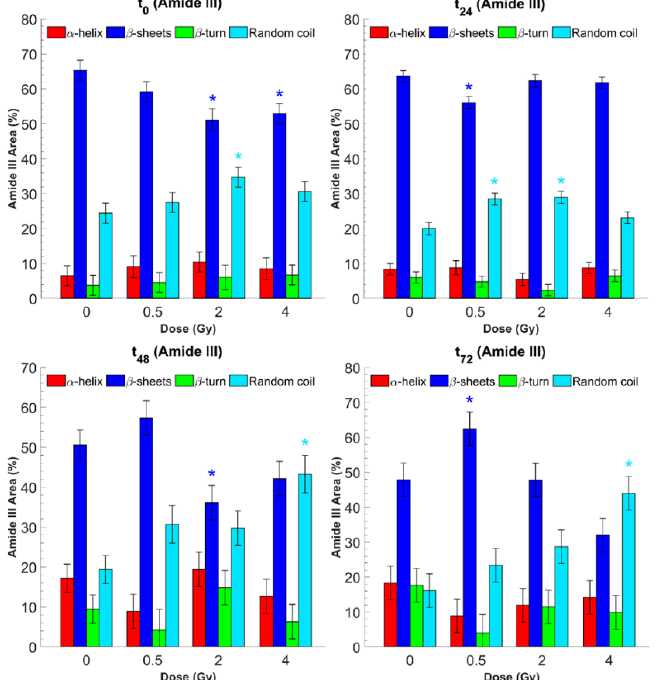
Figure 3. Changes in secondary protein structure contributions to Amide III band (1350–1180 cm − 1 ) with dose for cells fixed immediately and 24 h, 48 h, and 72 h after irradiation; the ratios between the secondary structure peak areas and the area of the whole Amide III peak are reported as Mean ± SD. Asterisks indicate when a significant difference from the corresponding control value occurred at p ≤ 0.05.